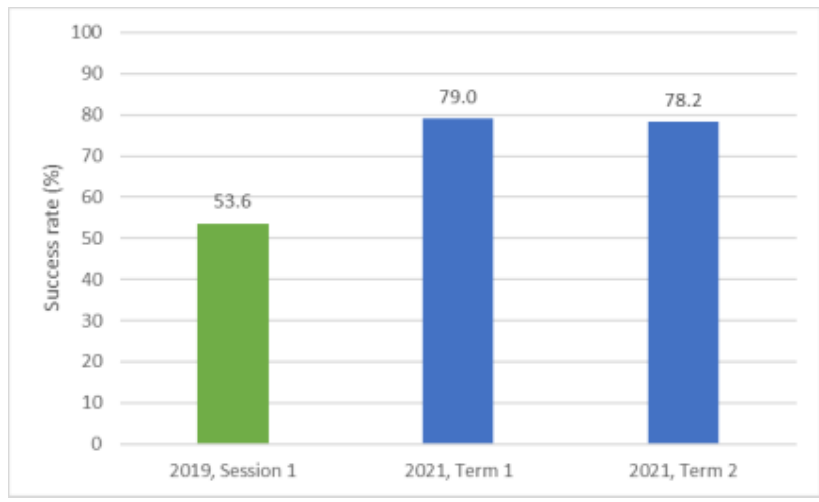
Success Rates of Enabling Cohorts in the Session (TDM) and the Terms